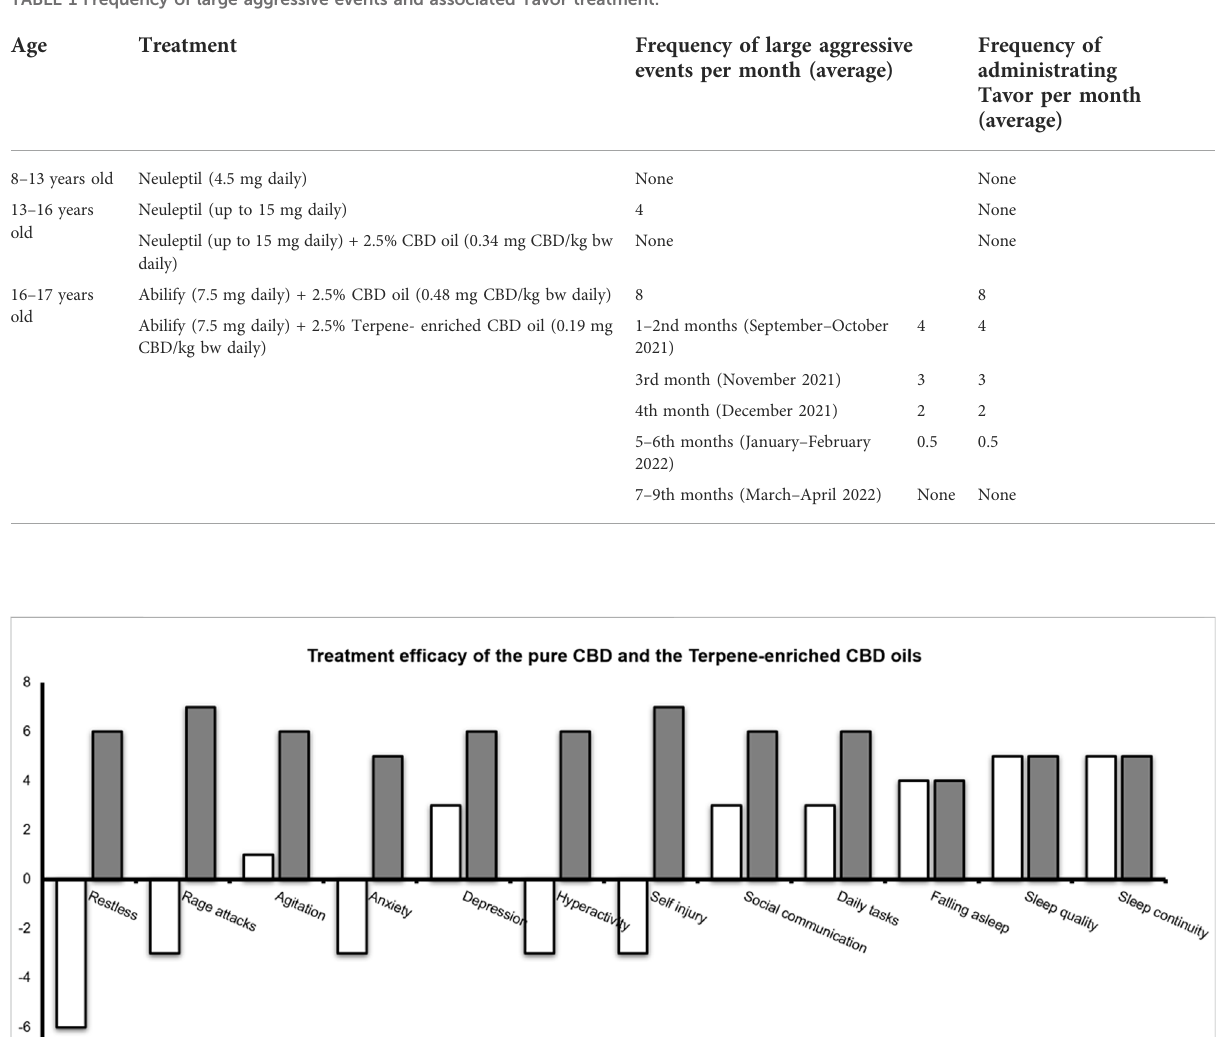
TABLE 1 Frequency of large aggressive events and associated Tavor treatment.